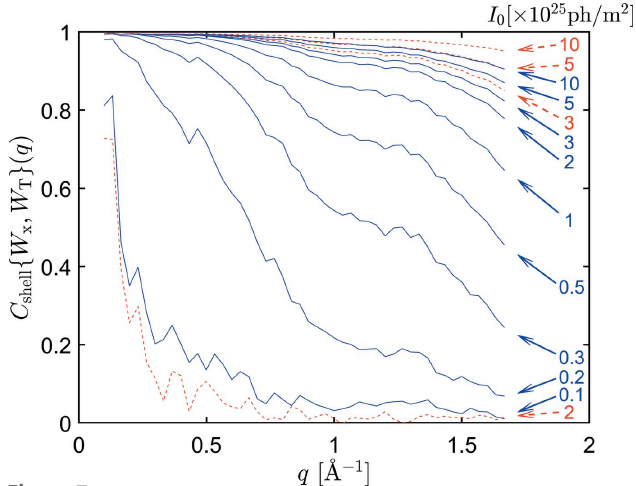
Figure 7 FSC between the 3D intensity volume W reconstructed by the EMC (blue solid lines) and CM (red dashed lines) methods and the ideally reconstructed intensity W T at various incident XFEL fluences for RNA polymerase